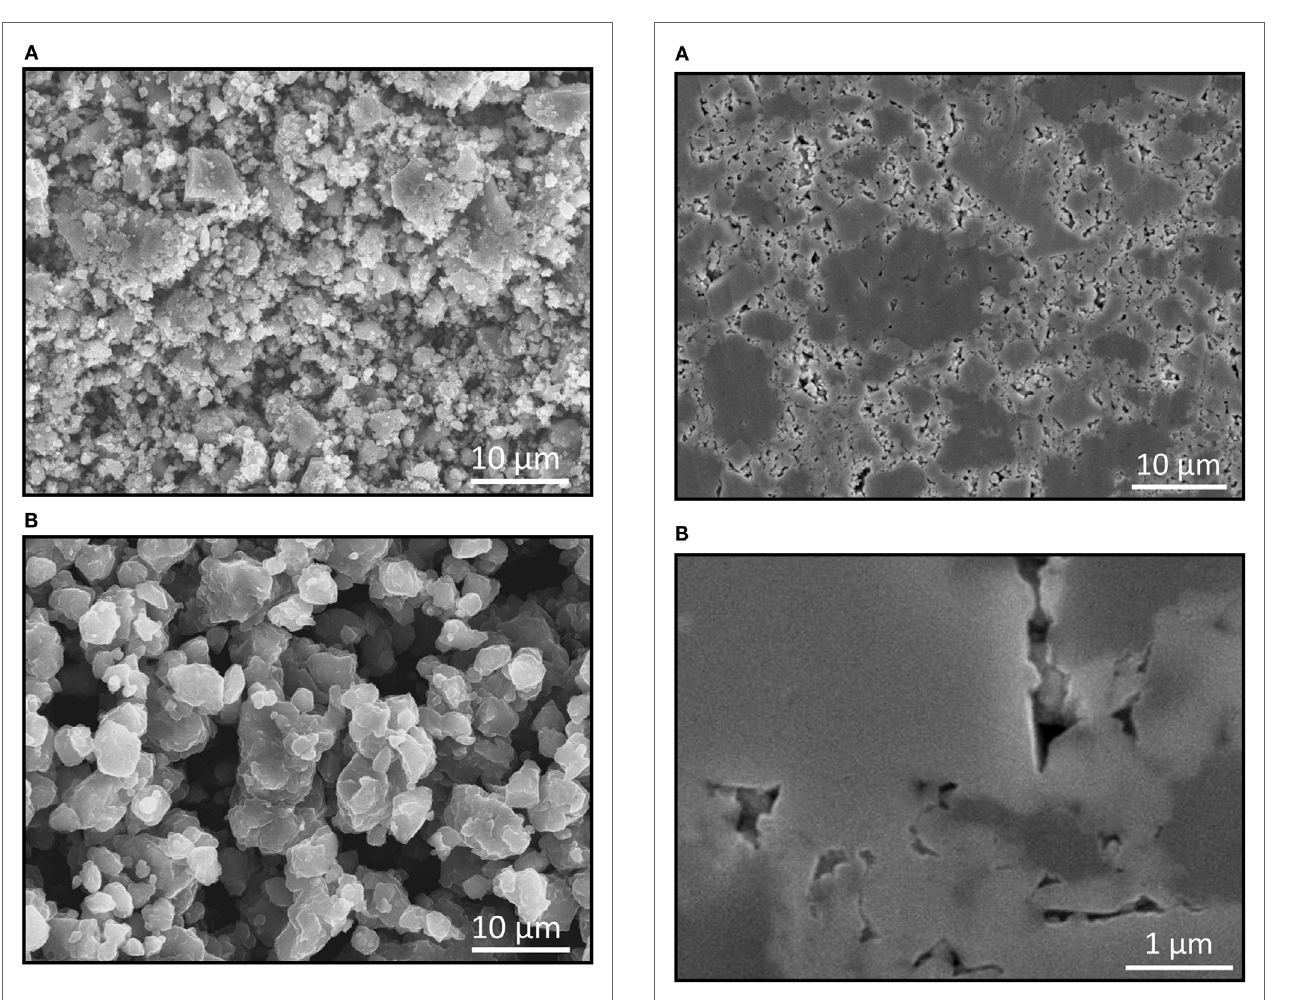
FigUre 3 | cross-sectional seM images of the composite electrode of the all-solid-state cell with li 3 nbs 4 . (a) Low- and (B) high- magnification